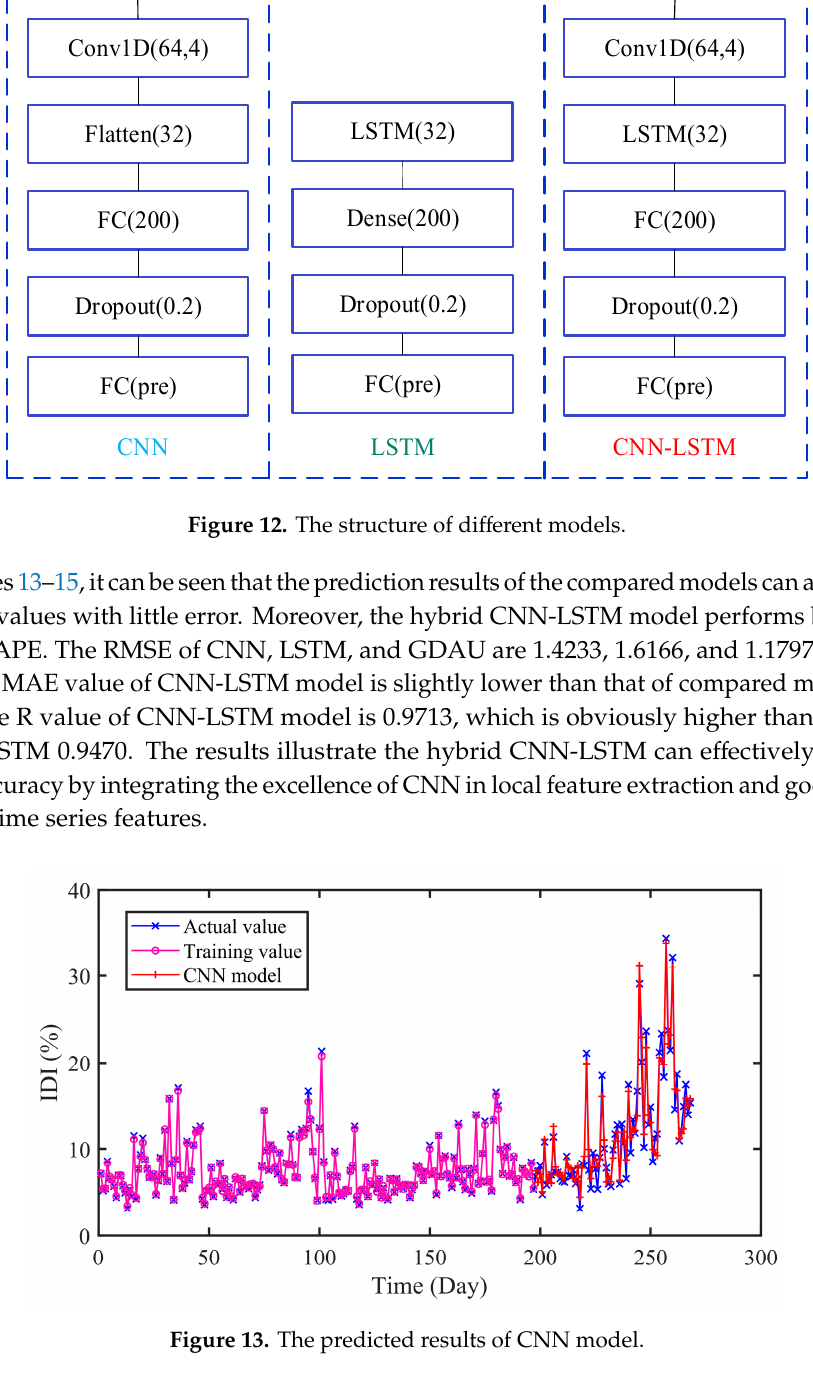
Figure 14. The predicted results of LSTM model . Figure 15. The predicted results of GDAU model . 4.5.3. Analysis and Discussion To compare the performance of various models more intuitively, the results achieved by comparative models are shown in Table 6 and Figures 16 and 17, respectively. The average performance improvement ratio is shown in Table 6 And the error distributions of all models are illustrated in Figure 16. Furthermore, the Taylor diagram is employed as illustrated in Figure 17. The standard deviations, centered root-mean-square and correlations are clearly exhibited.